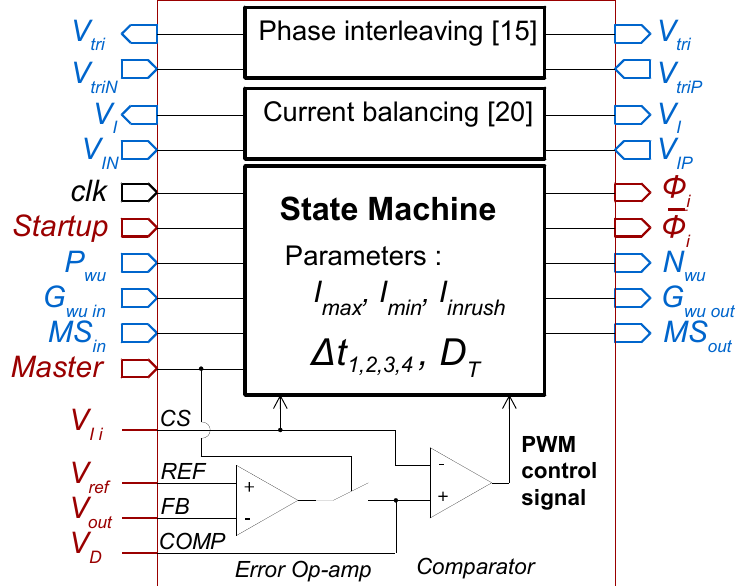
Figure 2. Implementation of the Local Controller including a current-mode voltage regulator, phase interleaving and current balancing decentralized functions, and a state-machine dedicated to im- plementing the decentralized phase-shedding function ( clk : clock signal for state-machine timing management; V tri , V triP , V trNi : triangular carriers dedicated to phase interleaving; V I , V IP , V IN : phase current measurement dedicated to current balancing).